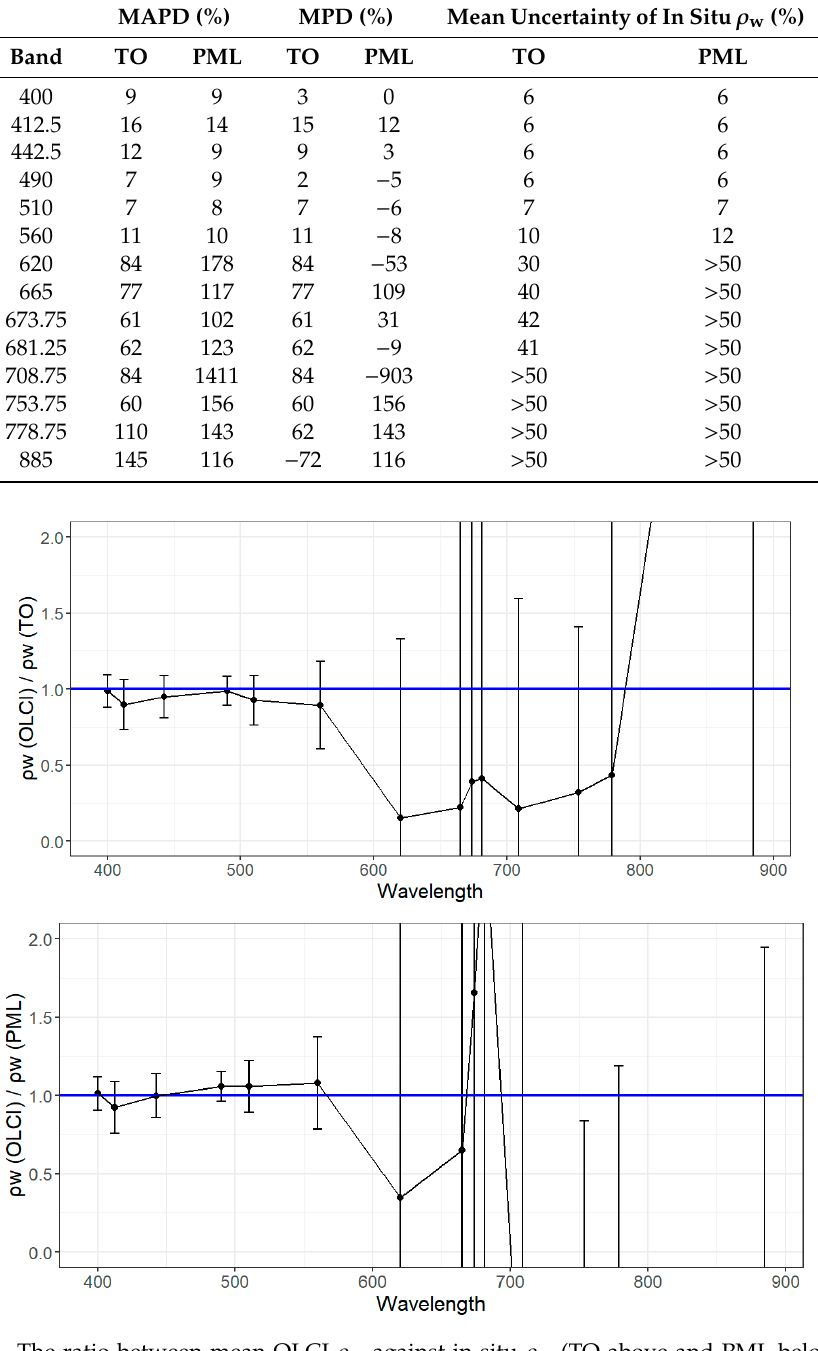
Figure 15. The ratio between mean OLCI ρ w against in situ ρ w (TO above and PML below) with straylight and NIR similarity corrections over four match-up stations (22, 32, 48, 56). The error bars denote the uncertainty for the ratio calculated from in situ and OLCI’s data.